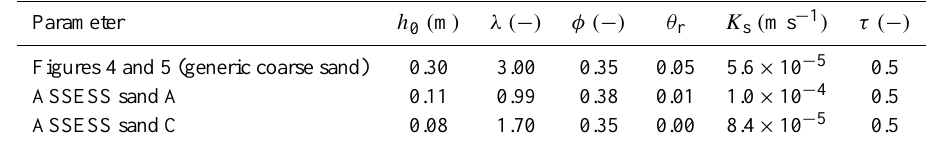
Table 1. Brooks–Corey parameters used for modeling soil hydraulic dynamics.